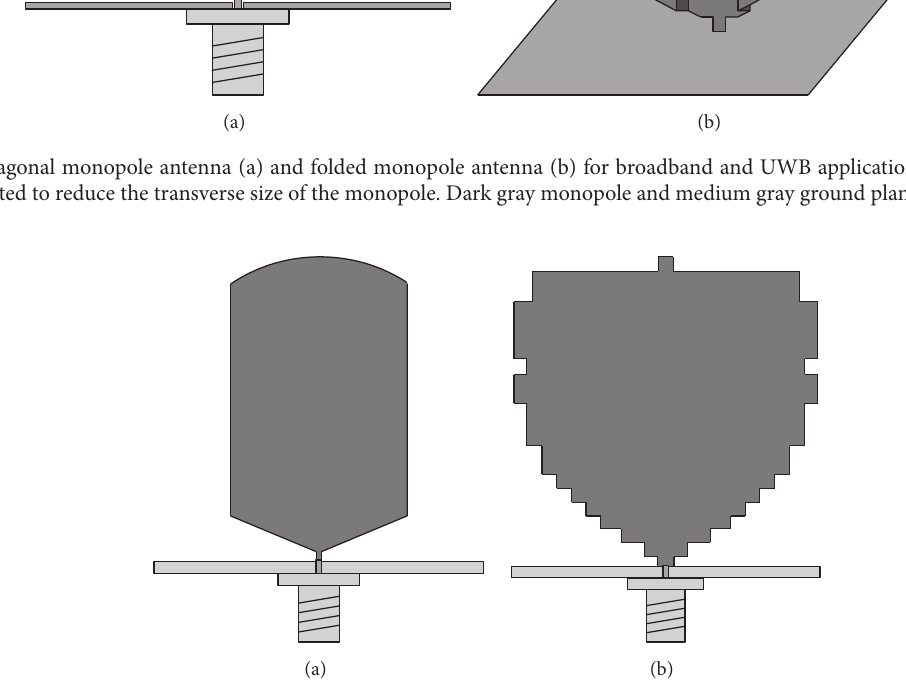
Figure 8: Monopole antenna (a) with bevels and (b) with staircase contours [26]. The bevels or the staircase contours are used to facilitate the energy emission in the monopole region near the ground plane. Dark gray monopole and medium gray ground plane.